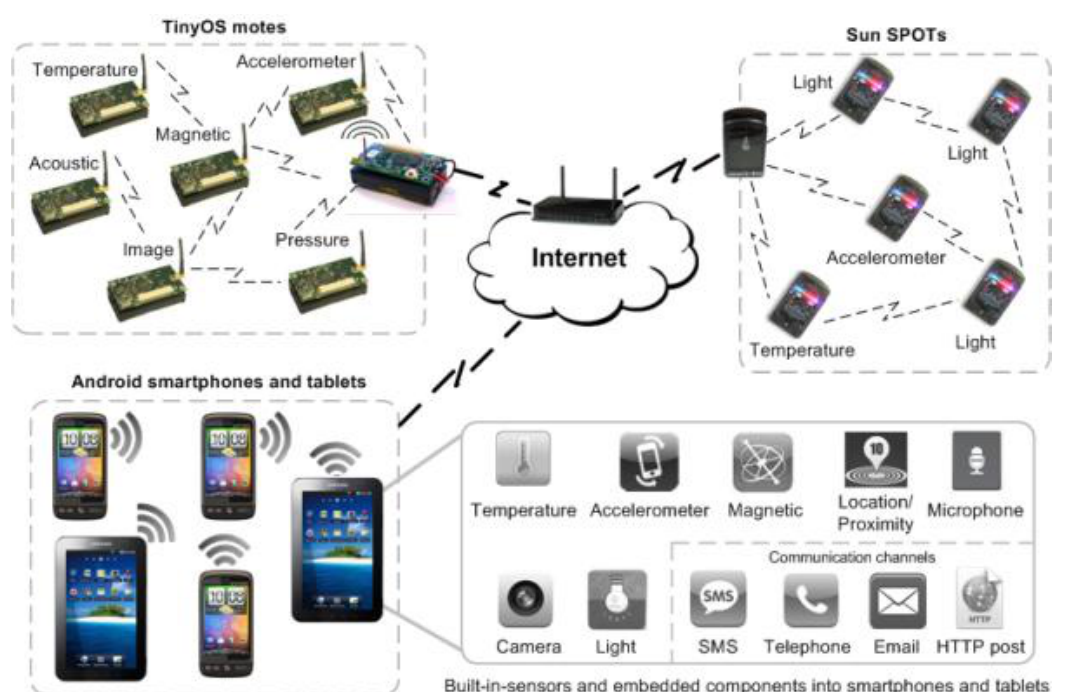
Figure 1. Architecture of a heterogeneous system made up of sensors and